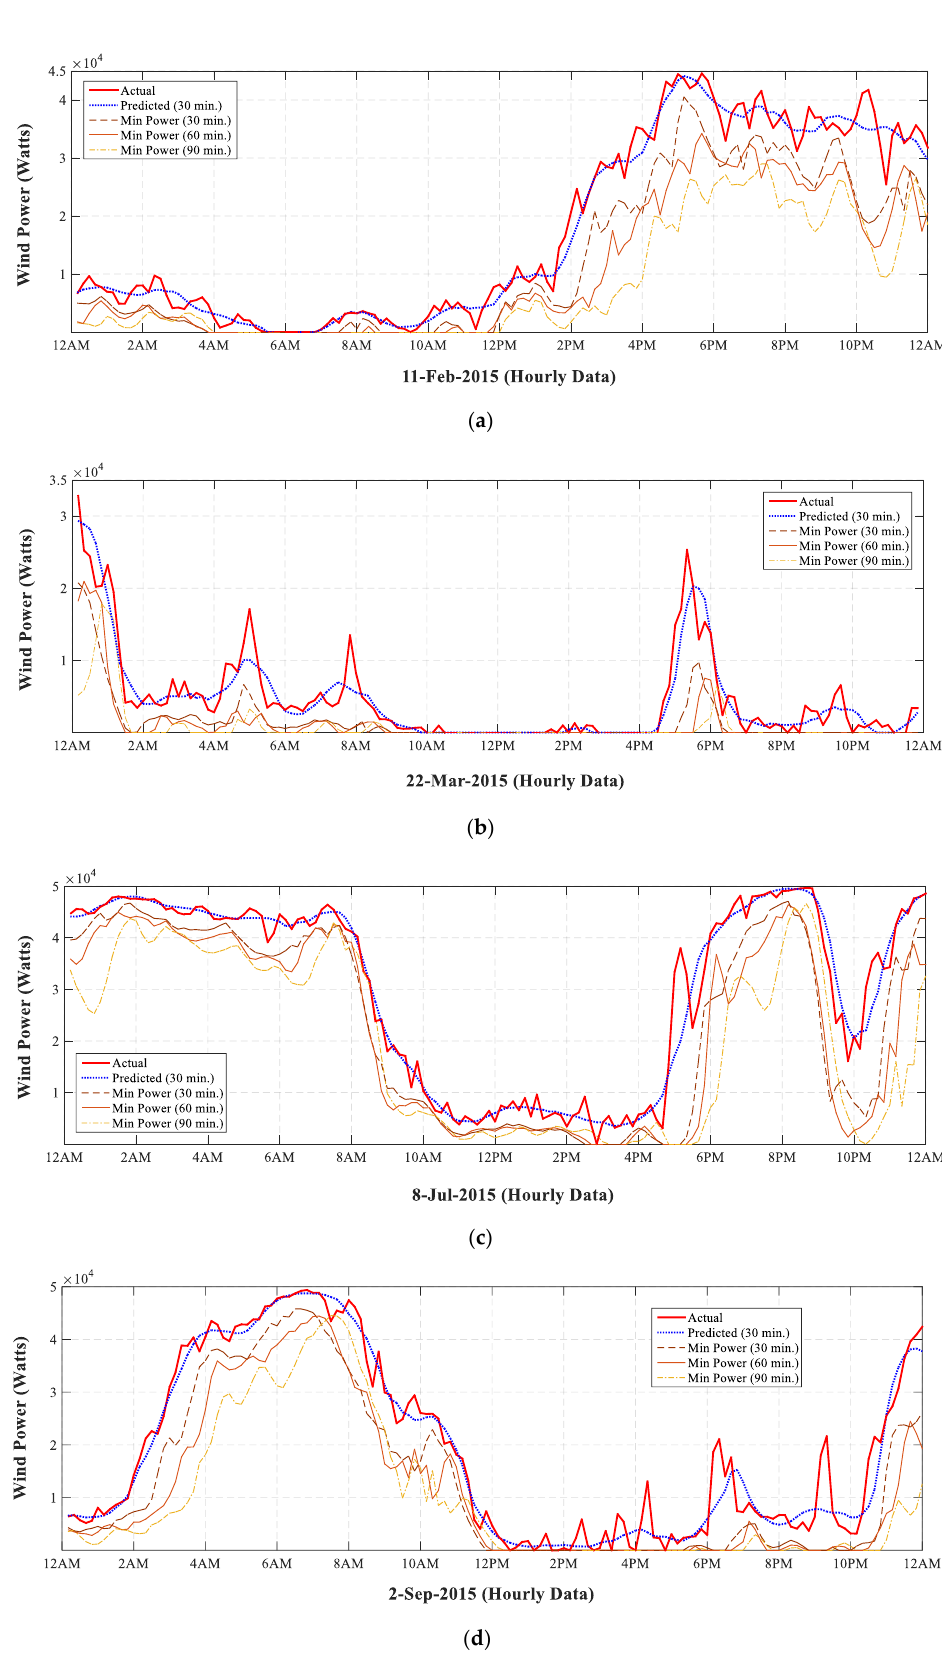
Figure 14. Actual generated power against estimated wind output power. The plots show a sample of four days in the year 2015: ( a ) 11th February, ( b ) 22nd March, ( c ) 8th July, and ( d ) 2nd September.